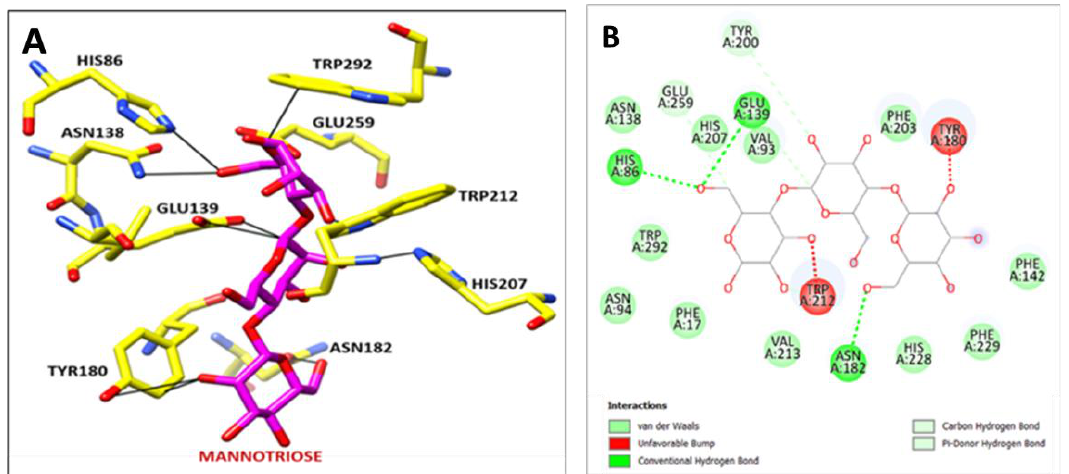
Figure 12. ( A ) Bonding interaction of active site residues of Mannanase (yellow) with Mannotriose (Magenta). ( B ) 2D-interactions between active site residues of mannanase with mannotriose. Table 3. Hydrogen-bonding interactions between mannanase with mannotriose. Sr. No.